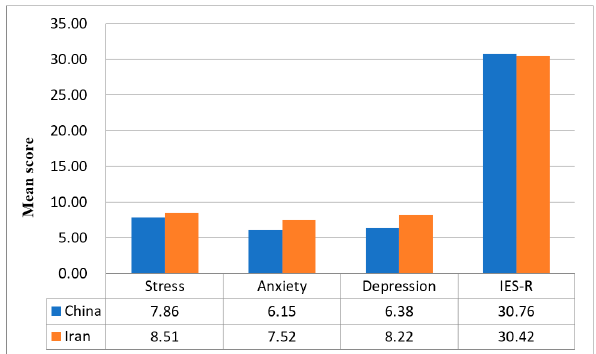
Figure 1. Comparison of the mean scores of DASS-stress, anxiety and depression subscales as well as IES-R scores between Iranian and Chinese respondents. 3.2. Comparison between Socio-Demographic Characteristics and Mental Health in Iranian and Chinese